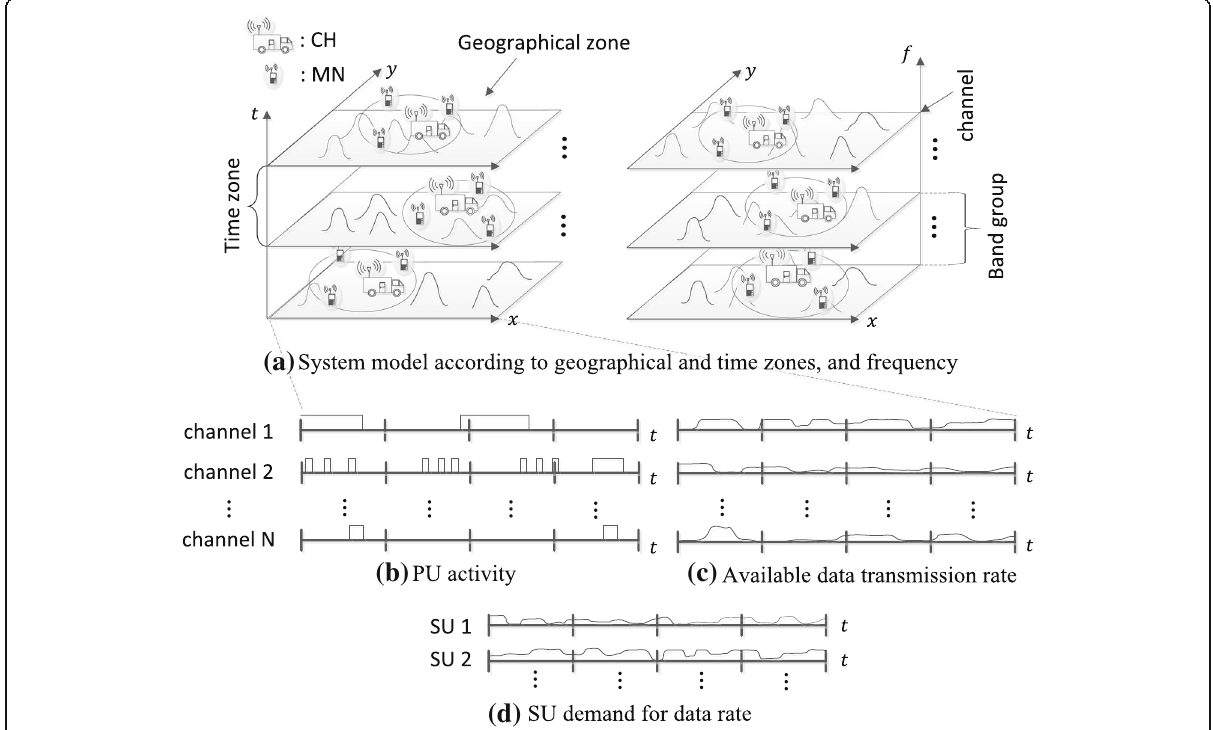
Fig. 1 Network model according to geography, time, and frequency. The cognitive radio ad-hoc network consists of a cluster head (CH) and mobile nodes (MNs) as shown in a . According to the time zone, band group, and each channel, the frequency resource is different. The PU activity, available data transmission rate, and SU demand for data rate vary according to the time and channel